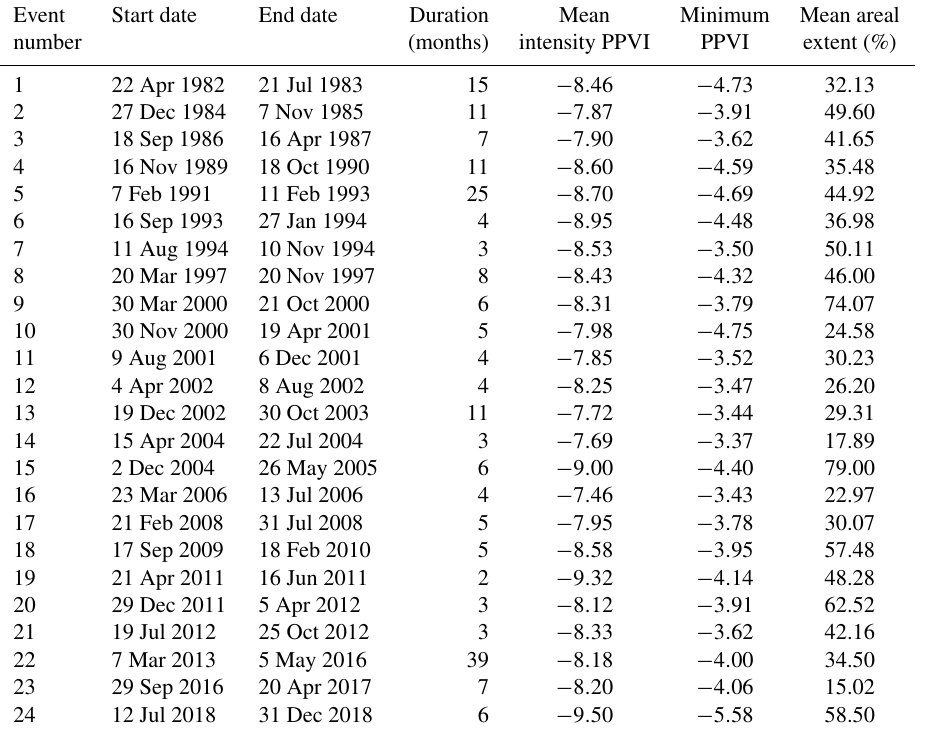
Table 12. Drought events in Haiti according to the PPVI, duration, severity and mean areal extent.